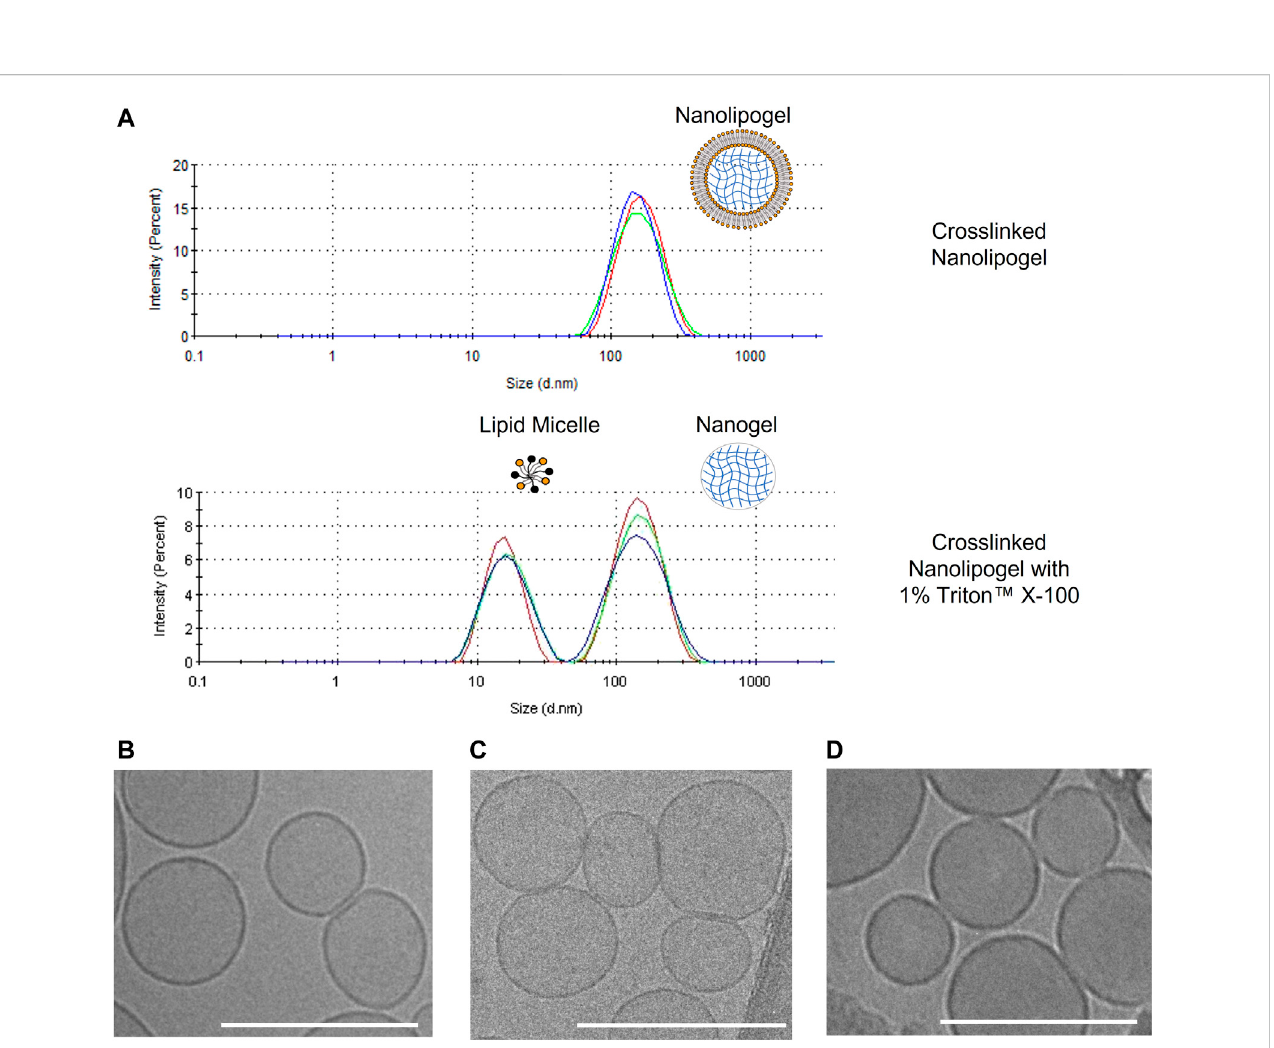
FIGURE 2 (A) DLS size distribution graphs of crosslinked PEGDA NLG and crosslinked PEGDA NLG with 1% Triton ™ X-100; Cryogenic-TEM images of (B) Bare Liposomes, (C) PEGDA 575 uncrosslinked NLGs, (D) PEGDA 575 crosslinked NLGs. Unmarked scale bars in the fi gures represent 200